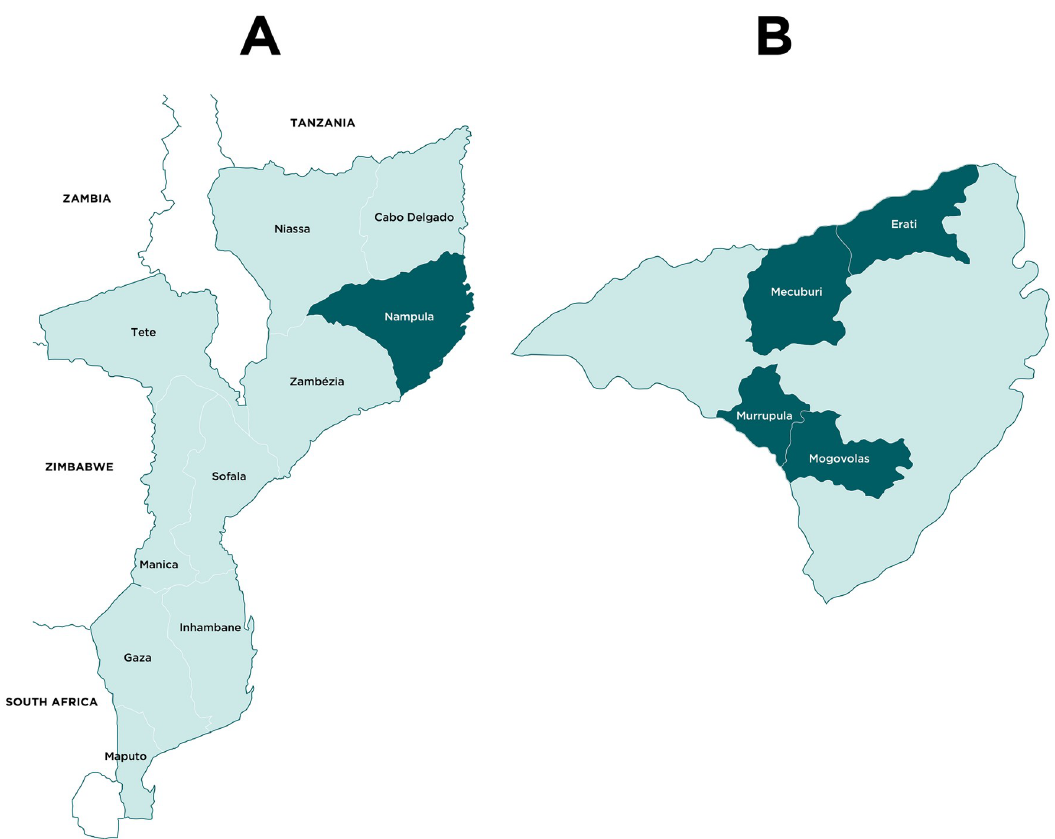
Fig 2. Maps of Mozambique (A) and Nampula province (B) with intervention districts highlighted dark green.